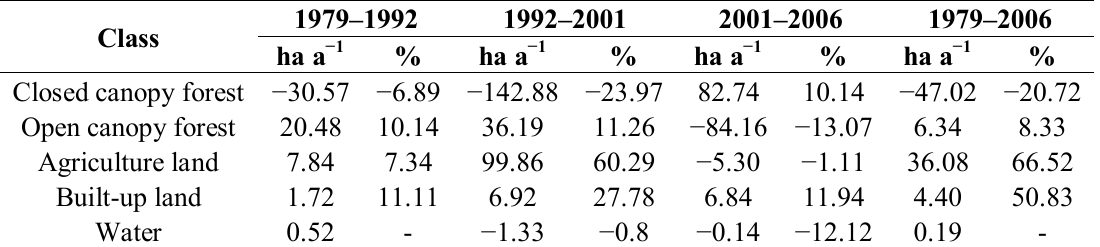
Table 2. Land-cover change dynamics during